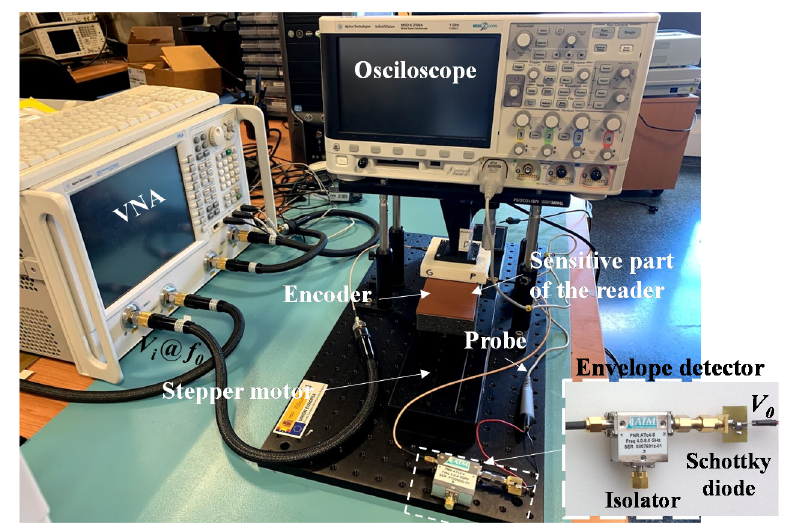
Sensors 2020 , 20 , x FOR PEER REVIEW Figure 7. Photograph of the experimental setup. Figure 7. Photograph of the experimental setup.